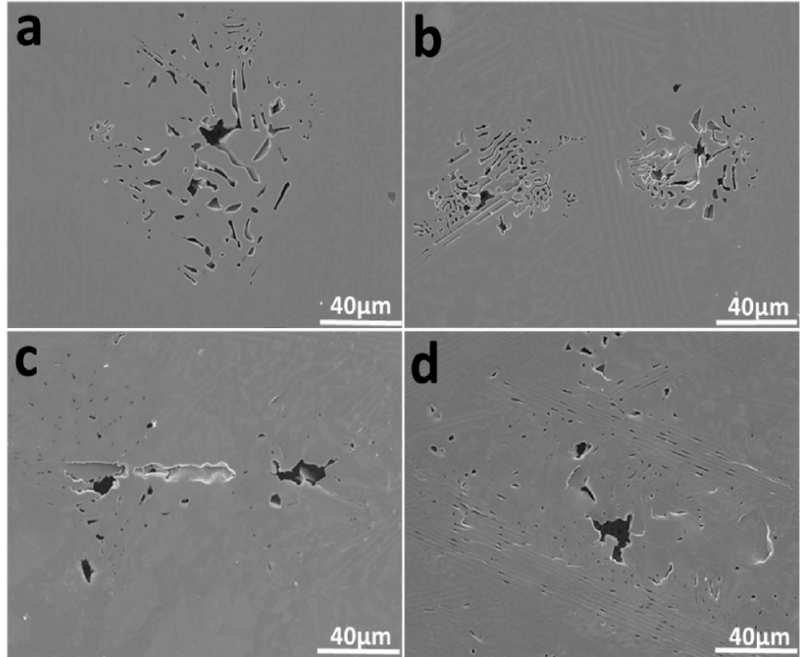
Figure 12. Pitting of AlCoCrFeNi 2.1 in chloride-containing sulfuric acid solution at: ( a ) 5 ℃ ; ( b ) 25 ℃ ; ( c ) 40 ℃ ; ( d ) 60 ℃ .